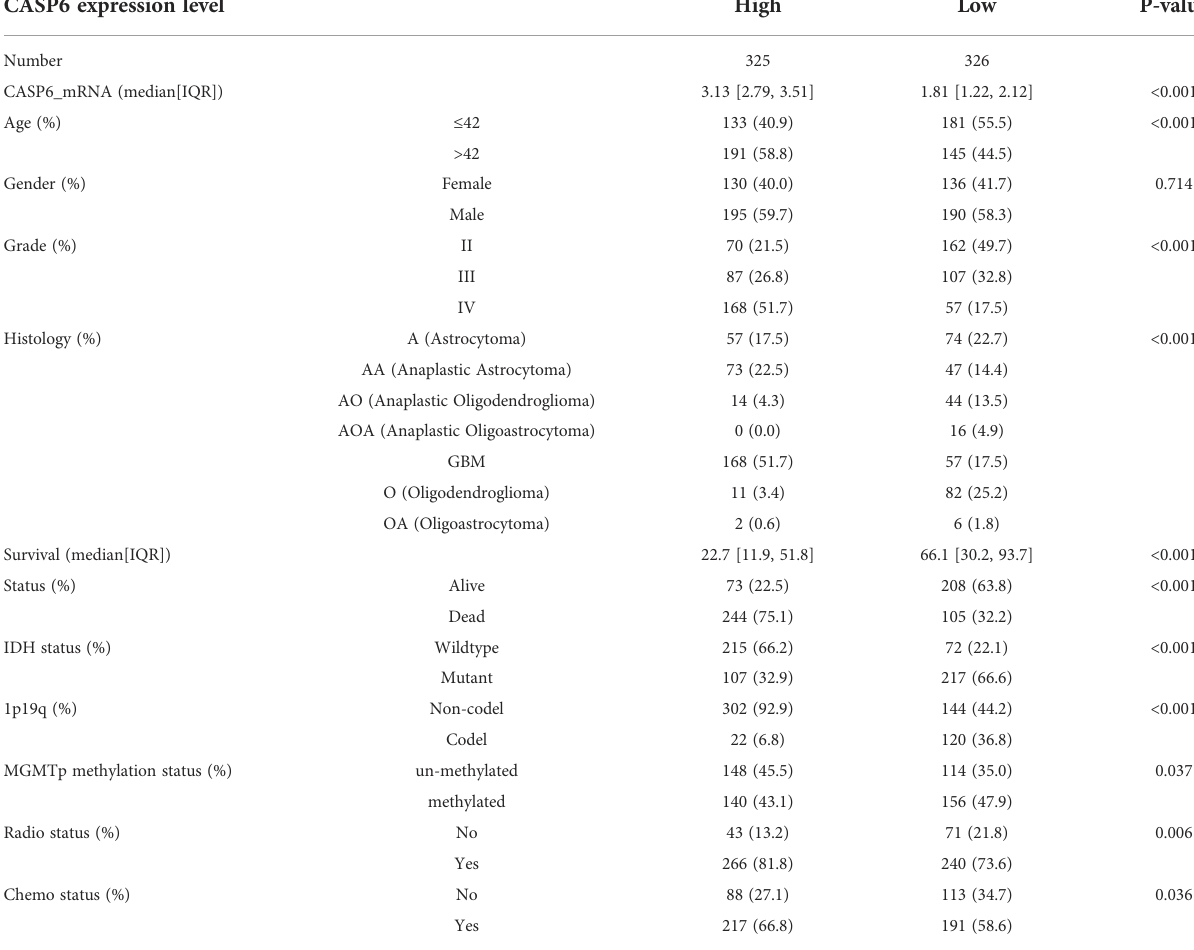
TABLE 1 Clinical characteristics of 651 patients with primary glioma in the CGGA dataset according to CASP6 expression.